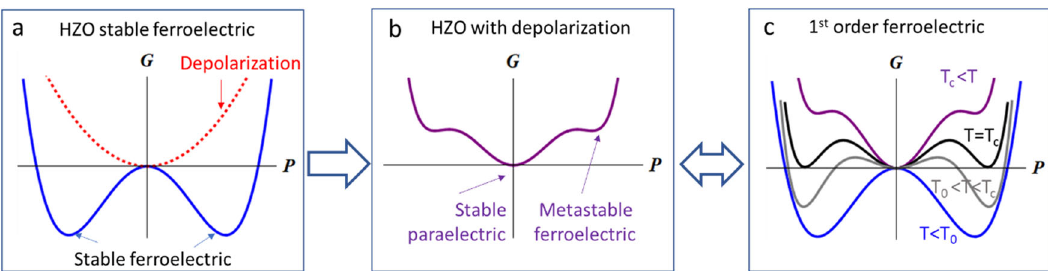
Fig. 9 Illustration of the effect of depolarization on the Gibbs free energy potential. a Double potential well showing a stable ferroelectric state (blue solid line). The presence of depolarization adds a quadratic (~ P 2 ) energy term represented by the red dashed parabola. b The convolution of a double potential well with a parabolic term coming from depolarization yields the triple potential well, which resembles a 1st order ferroelectric above T c . c The temperature (T) dependence of Gibbs free energy for a 1st order ferroelectric. T 0 and T c are the Curie – Weiss and Curie temperatures, respectively. For T < T T T < T 0 (blue curve) the material is a stable ferroelectric. For 0 < c (gray curve), the material has a stable ferroelectric state coexisting with a metastable paraelectric one ( P = 0). For T > T c (magenta curve), the material shows a stable paraelectric ( P = 0) phase coexisting with a metastable ferroelectric one yielding a triple potential well similar to that in ( b